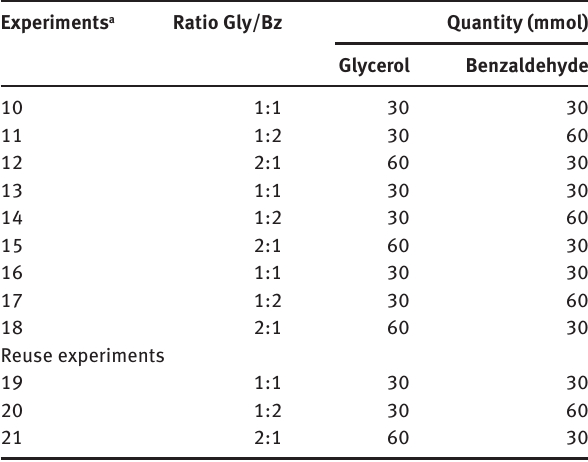
Table 2: Performed experiments with organic solvents and catalyst